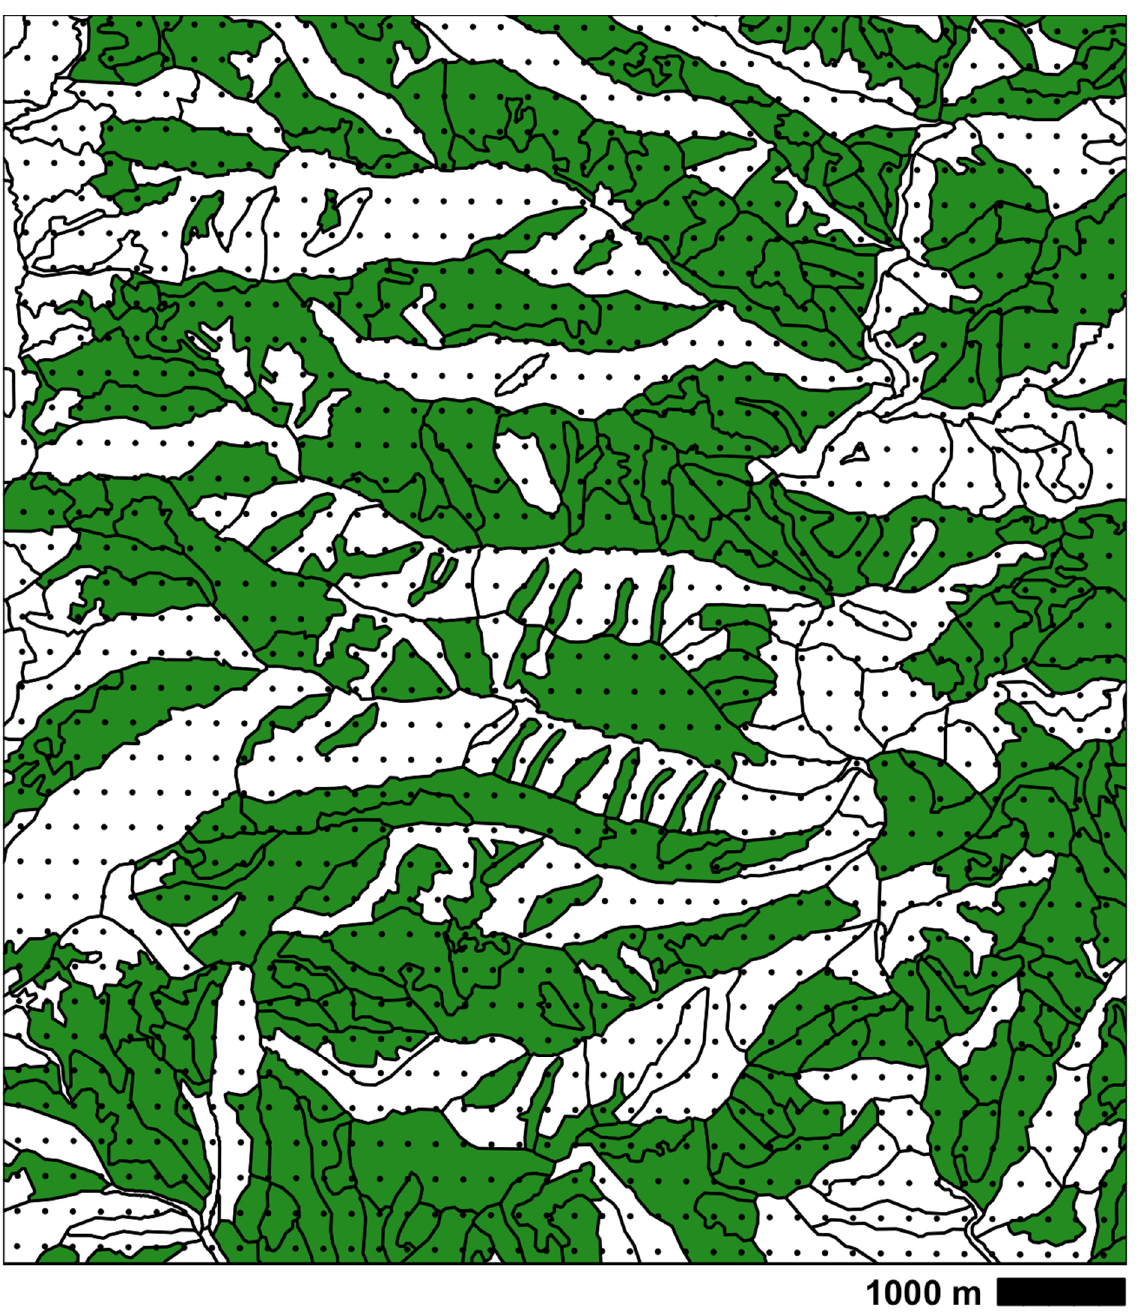
Figure A2. An example of vegetation polygons and their sampling from the San Juan National Forest. Shading indicates presence of Populus tremuloides ; black dots indicate a sampling grid with spacing of 0.0025 degrees. At this scale, presence/absence is strongly influenced by topography. Elevation of the map ranges from 2390 to 3530 m.